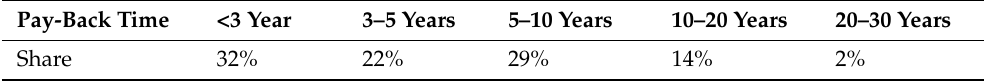
Table 4. Breakdown of the potential savings obtainable from EE interventions based on PBT. Pay-Back Time